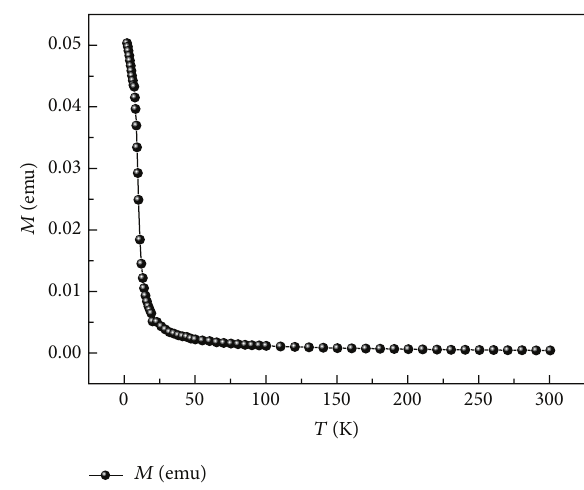
Figure 3: 𝑀 versus 𝑇 for the